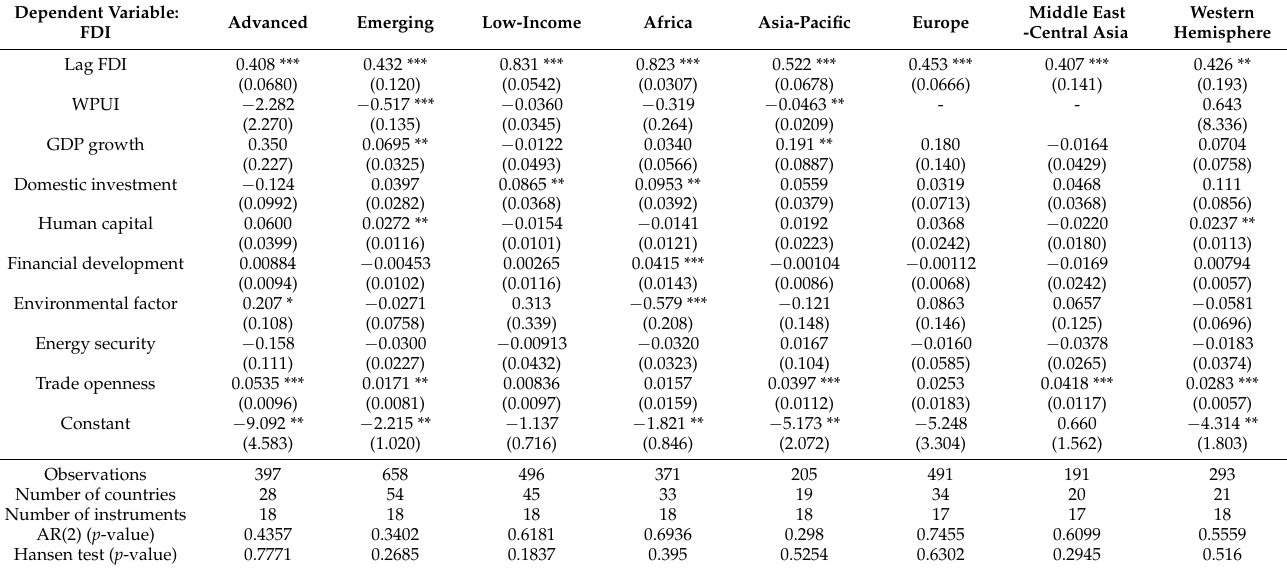
Table 3. World Pandemic Uncertainty Index and FDI by income and